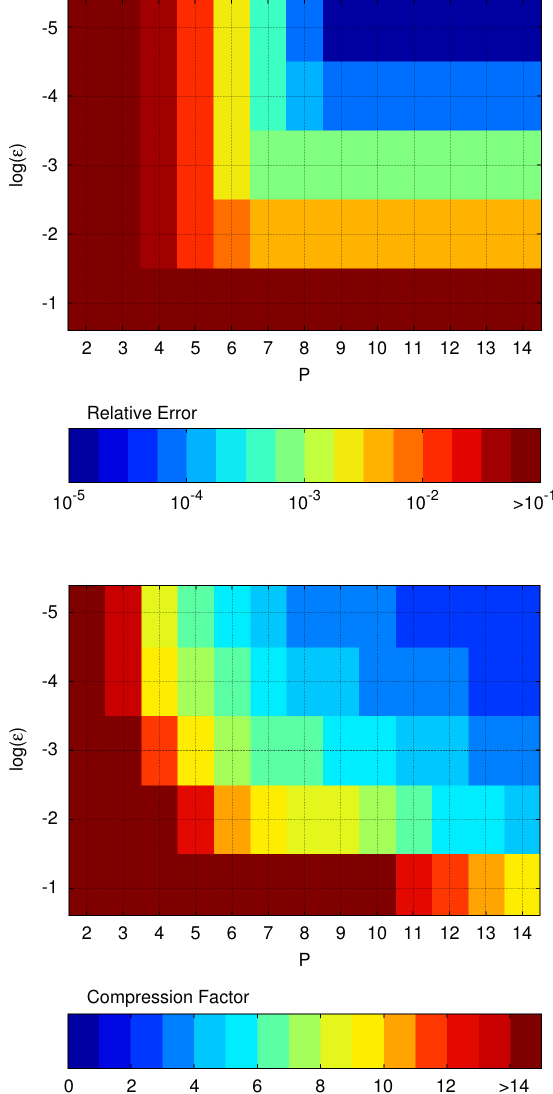
Figure 3: Top: Relative error of the aggregation matrix F θ estimated in Frobenius norm [8]. Bottom: Compres- sion factor for aggregation matrix (compared to a non- compressed matrix). P : Maximum order of spherical har- monics. (cid:15) : Accuracy of compression with TSVD. Example: Flat plate included in a group with 0 . 5 λ edge length as de- picted in Fig.